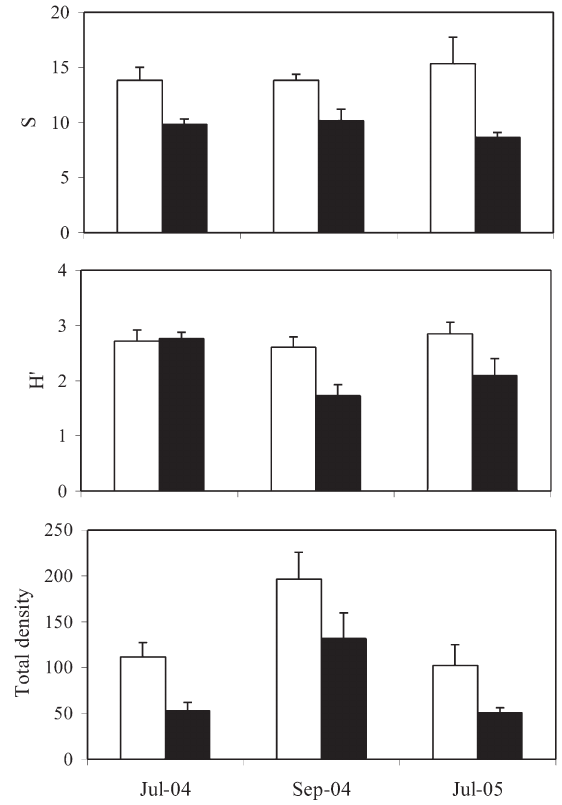
Fig . 2. – Mean (+SE) species richness (S), diversity (H’) and total density (number of individuals per pyramid) of fishes recorded at Capo S. Marco (white bars) and Torre Verdura (black bars) accord- ing to sampling